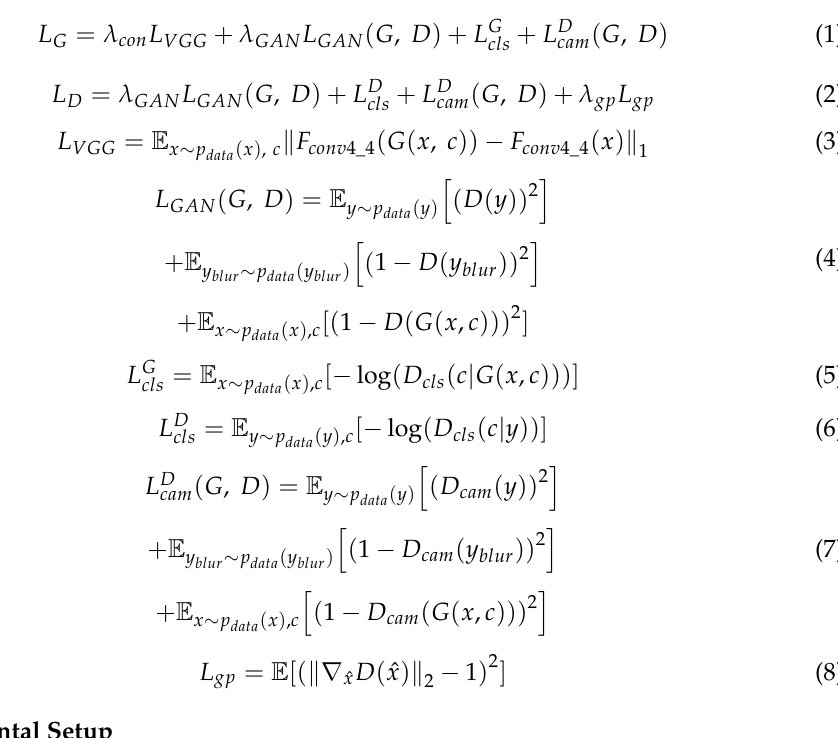
Figure 3. Overview of conditional adaptive instance-layer normalization. CAM logits are output through adaptive average-pooling and adaptive max-pooling layers. G seeks to deceive D so that both the feature patches and the CAM logit are